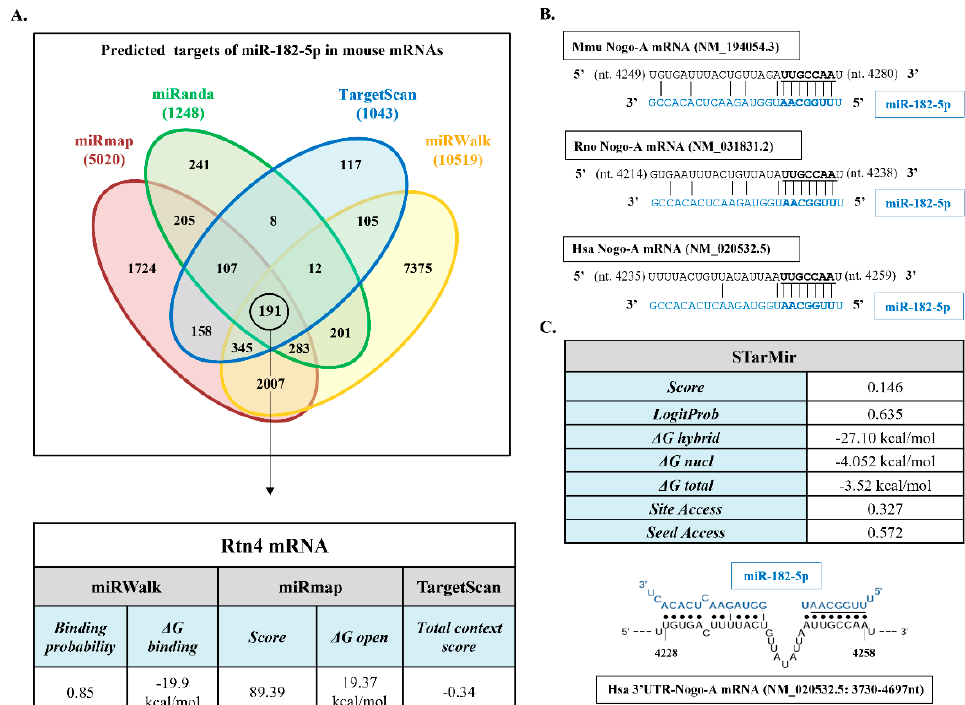
Figure 1. Bioinformatics analyses. ( A ) Description and main data of the process of identification of mouse RTN4 gene (Nogo-A) as miR-182-5p-predicted target by miRmap, miRanda 3.3a, TargetScan 8.0, and miRWalk 3.0. The table shows the algorithm prediction scores, binding probability, free energy gained by transitioning from the state in which the miRNA and the target are unbound ( ∆ G open) (kcal/mol) and the state in which the miRNA binds its target ( ∆ G binding), according to each algorithm. ( B ) Alignment of the seed region of miR-182-5p with the Nogo-A 3 ′ UTR in mouse (Mmu), rat (Rno), and human (Hsa) mRNAs. MiR-182-5p sequence appears in blue type, and miRNA seed regions appear in bold type. ( C ) Main data of the target site accessibility and hybrid diagram seed site of miR-182-5p on human Nogo-A 3 ′ UTR by STarMir tool. MiR-182-5p sequence appears in blue type, and miRNA seed region appears underlined.